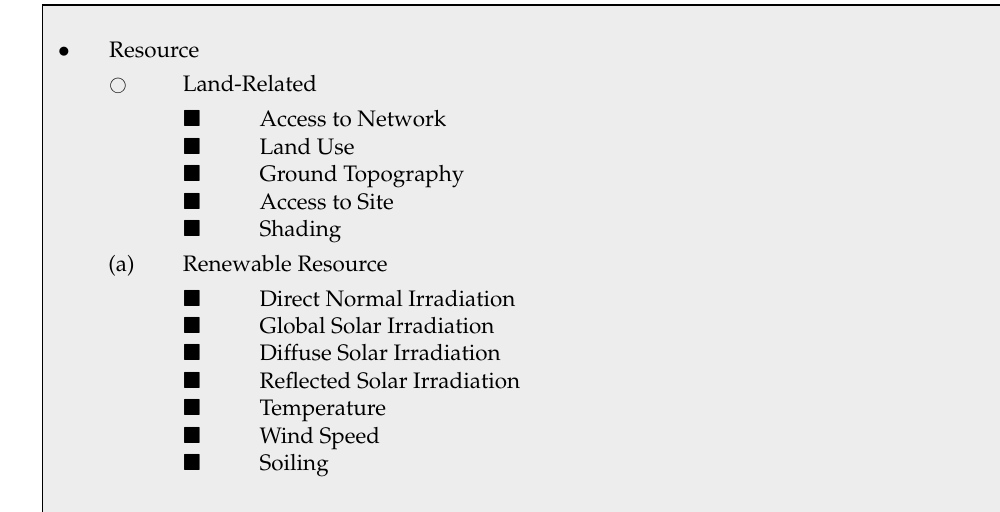
Table 4. Hierarchy for Resource-related topics in the Production of Electricity from Solar PV.